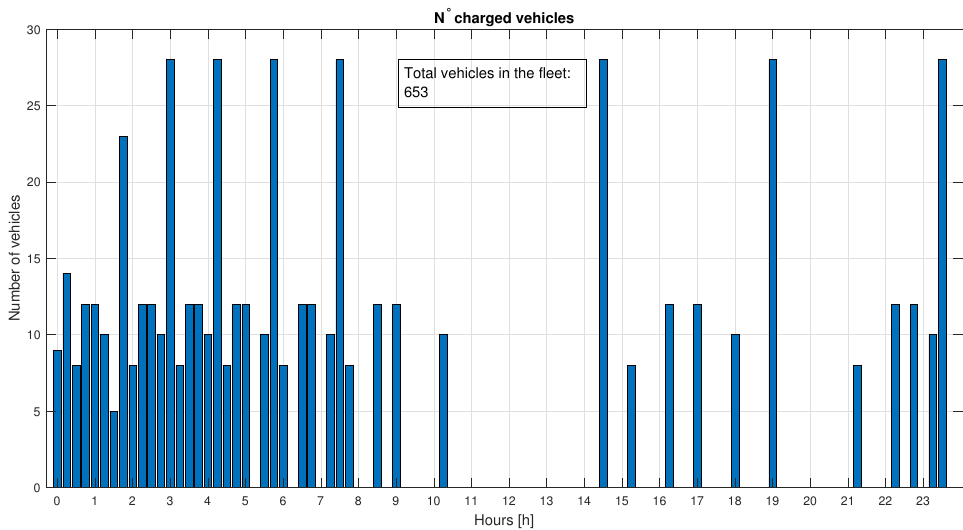
Figure 7. Connection with uniformly distributed SoC